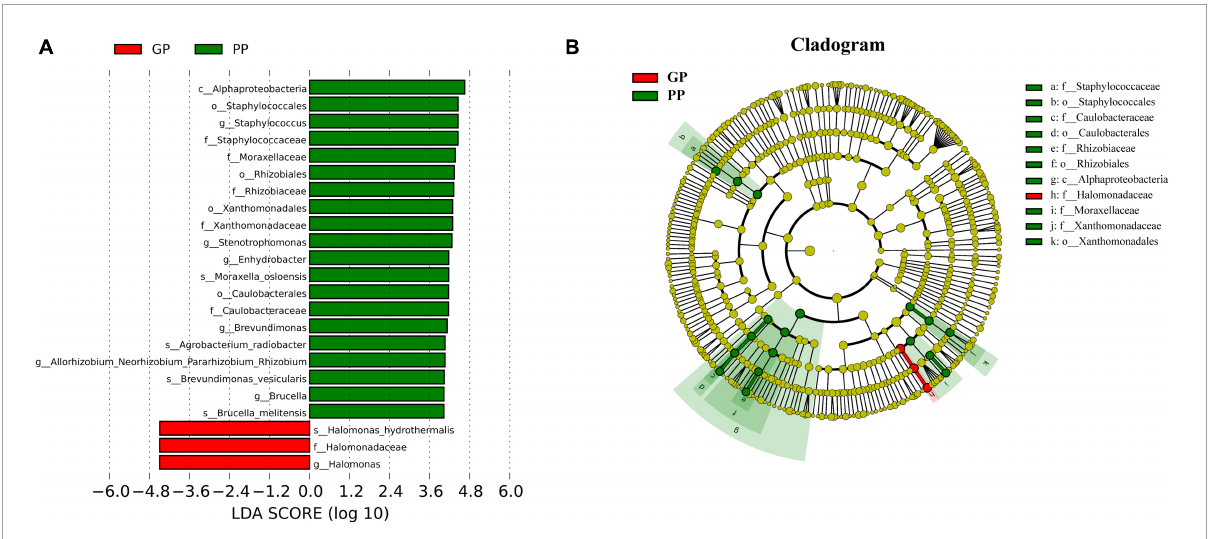
FIGURE2 Composition and linear discriminant analysis of skin microbiota between PP and LPP groups. (A) Cladogram generated from the LEfSe analysis indicates the phylogenetic distribution of the microbiota of PP and GP groups from phylum to genus. (B) Histogram of LDA scores to identify differentially abundant bacteria between PP and GP. The threshold of linear discriminant analysis score was set as 4, and the larger the LDA score is, the greater differences among the three groups